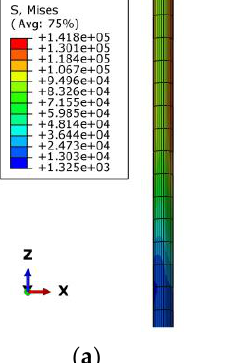
Figure 10. The von Mises stress of the conductor, where ( a ) is calculated by the contact surface model and ( b ) is calculated by the Goodman contact element